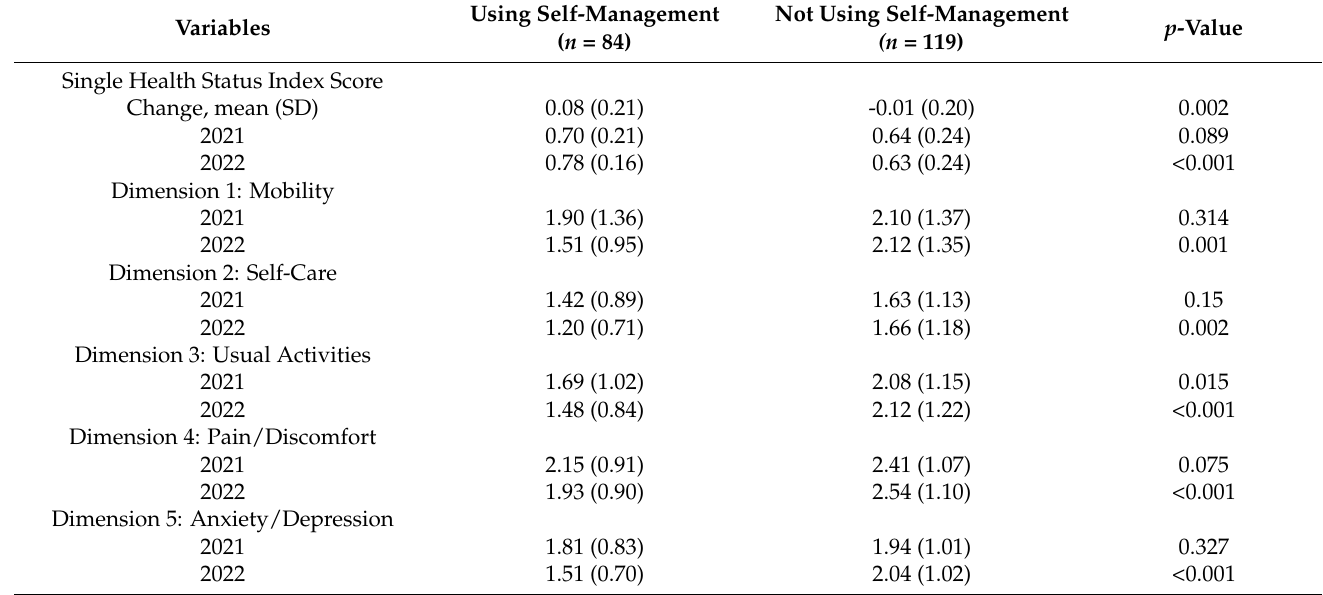
Table 2. Change in the single health status index scores on the